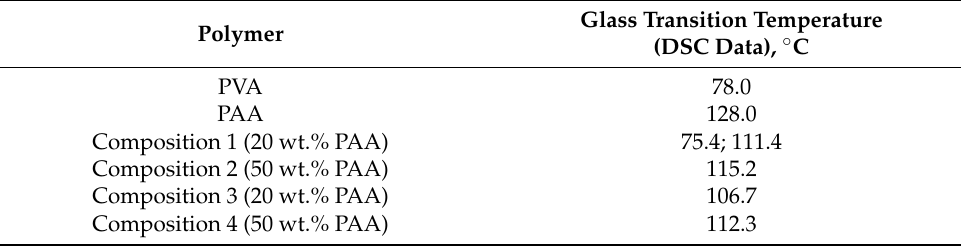
Figure 4. X-ray diffraction patterns of films prepared from PAA (curve 1), PVA (curve 2), and compositions 1–4 (curves 3–6, respectively). Table 1. Glass transition temperatures of PVA, PAA, and their